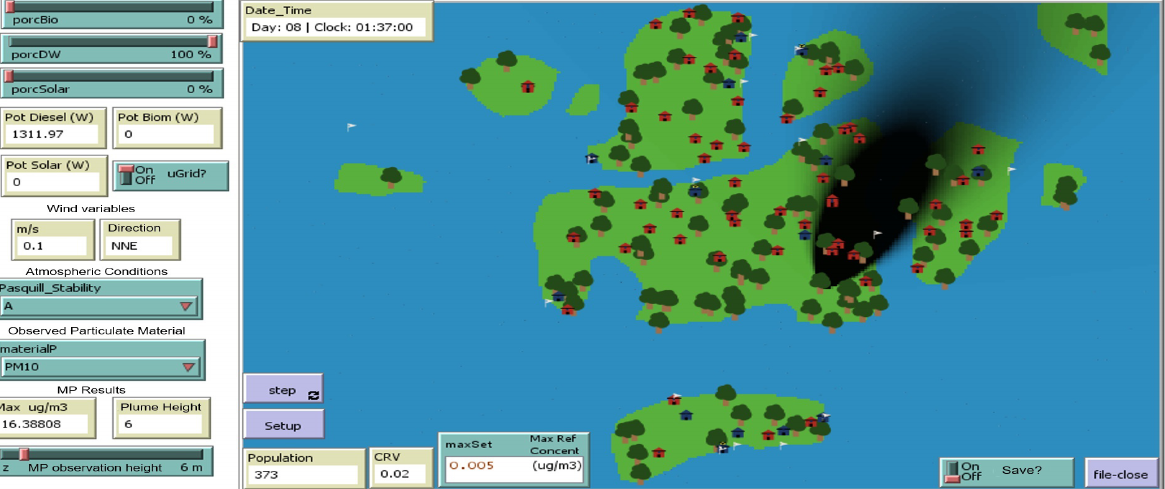
Figure 16. Particulate material dispersion model by Gaussian plume approximation applied in the socio-technological model and implemented in Netlogo. Wind in direction NNE . Atmospheric stability Pasquill A (Unstable). Pollutant PM 10 .